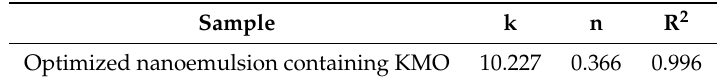
Figure 7. Graph of viscosity (Pa.s) versus shear rate (s − 1 ). Table 8. Flow behavior indices (n), consistency coefficients (k), and regression coefficients (R 2 ) of the optimized nanoemulsion containing KMO.